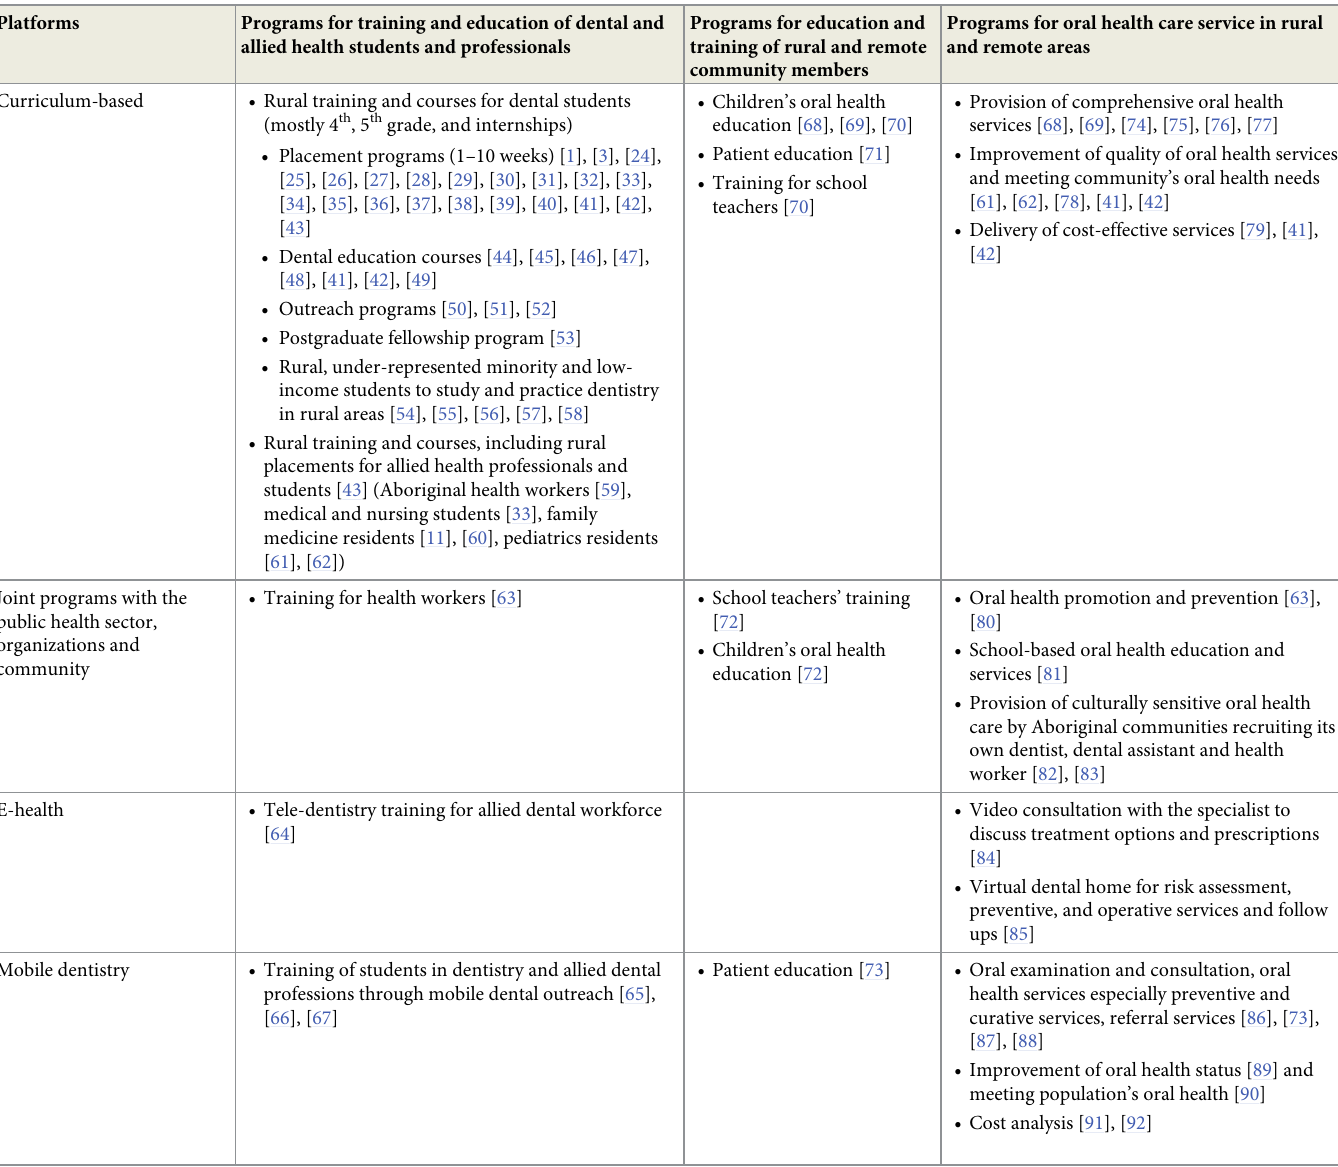
Table 2. Description of program platform themes based on program